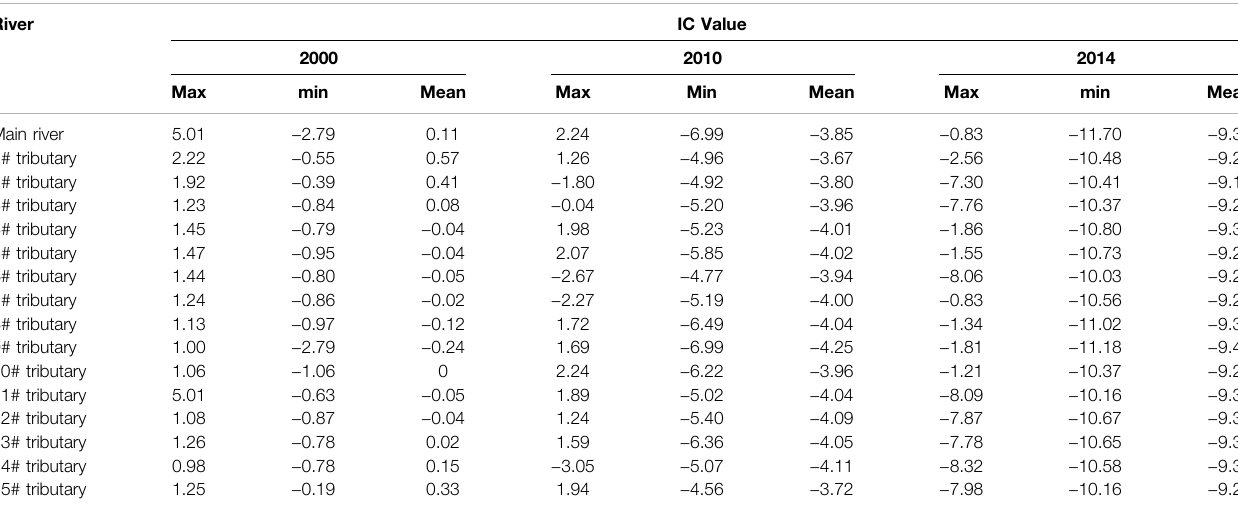
TABLE 2 | Sediment connectivity index (IC) values in 2000, 2010, and